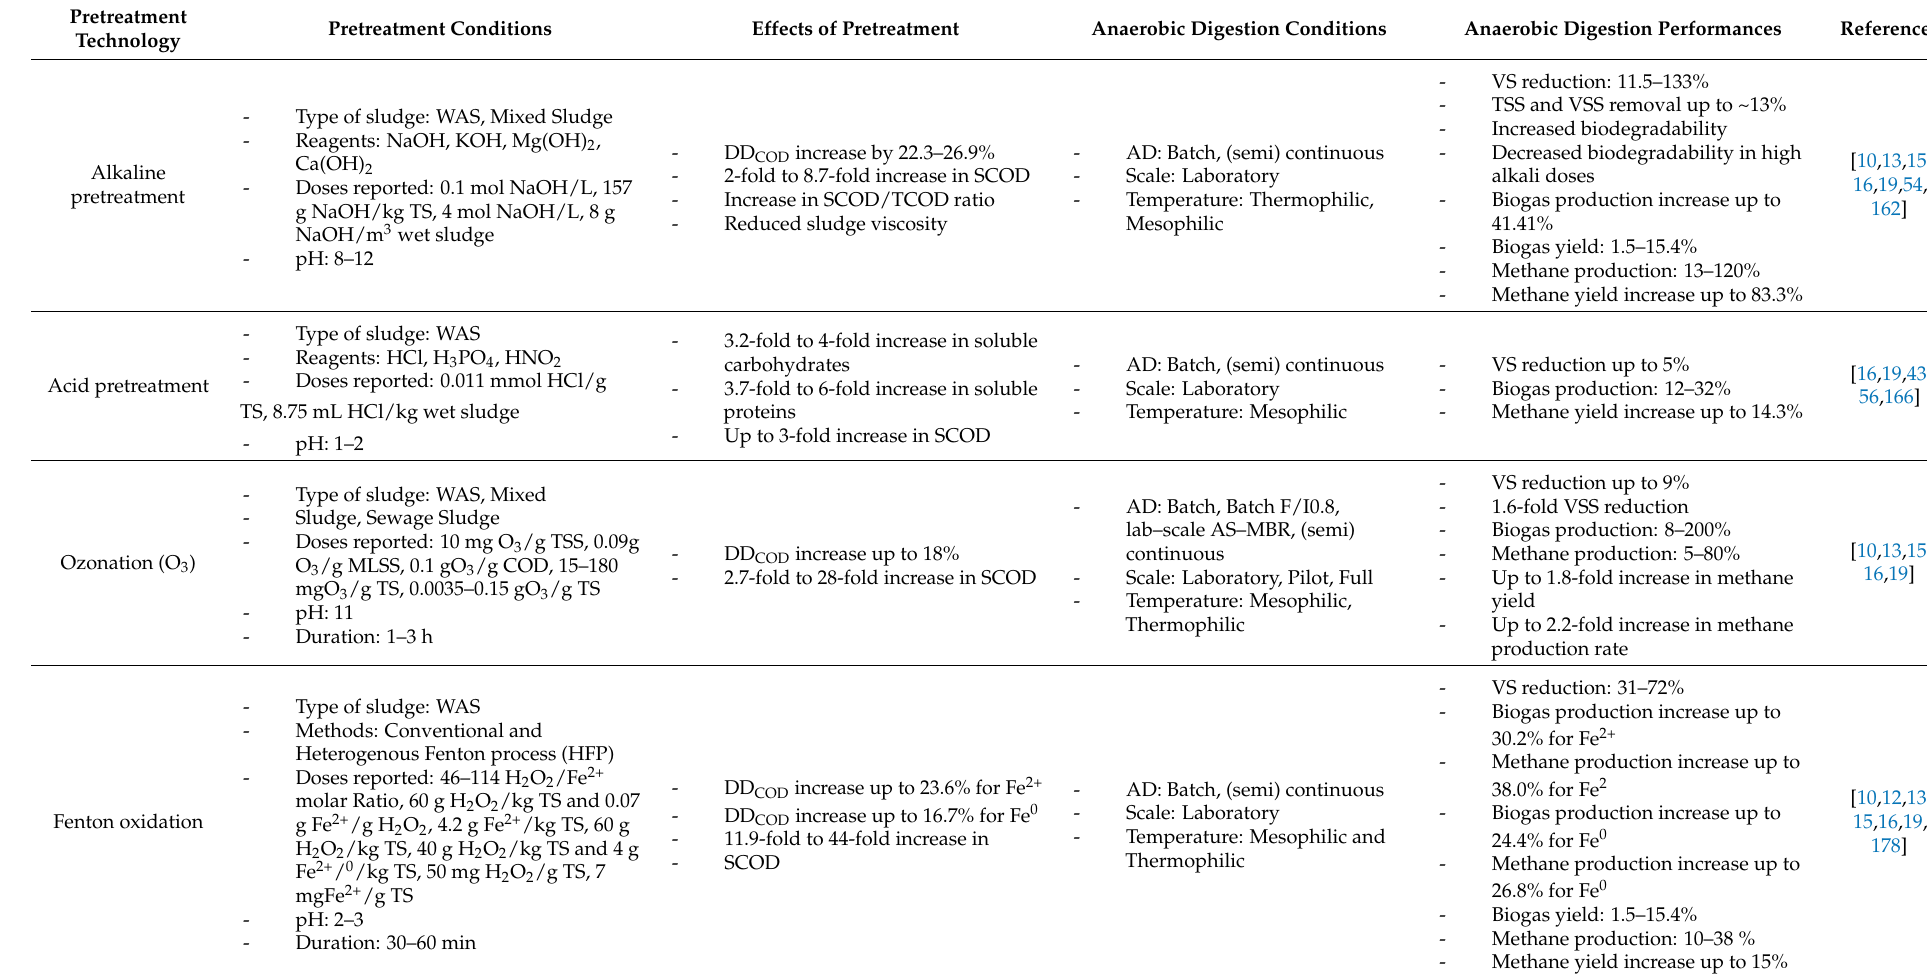
Table 3. Effects of chemical pretreatment methods on anaerobic